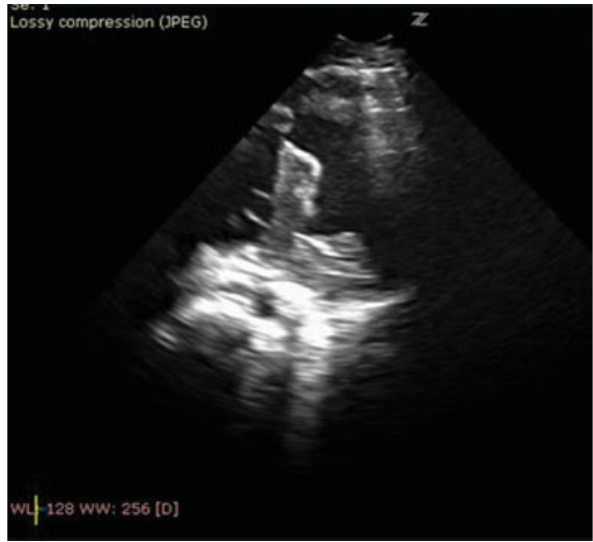
Fig. 5 VSD closed with a PTFE patch with repair of the RV wall. PTFE, polytetra fl uoroethylene; RV, right ventricular; VSD, ventricular septal